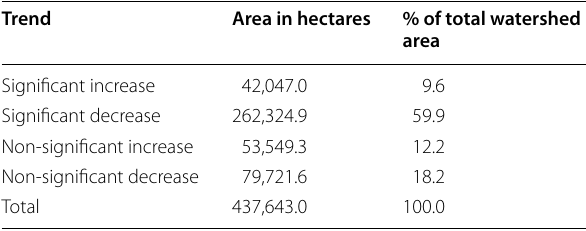
Table 1 Watershed level vegetation change trend